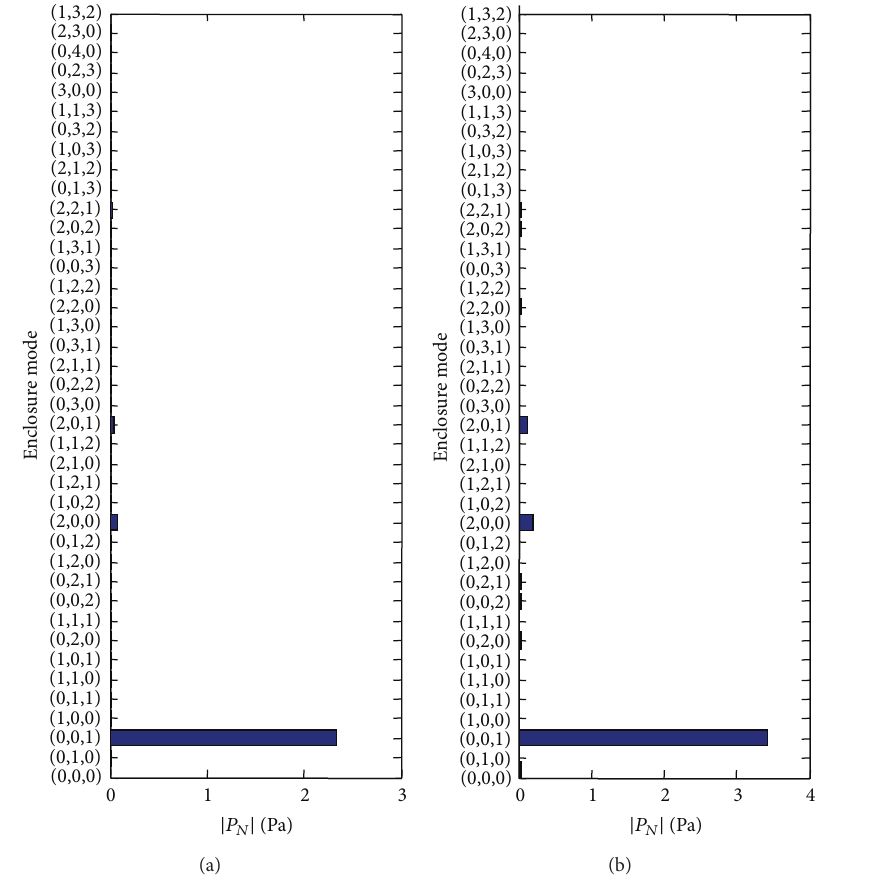
Figure 6: Modal amplitude of sound filed in the enclosure: (a) the (0,0,1) enclosure-controlled mode; (b) the (3,1) panel-controlled mode. = 0.6 m, 𝑇 = 15 s, 𝑇 = 0.5 ℎ = 0.00844 m, 𝐿 𝑍 𝑎𝑁 𝑝𝑀